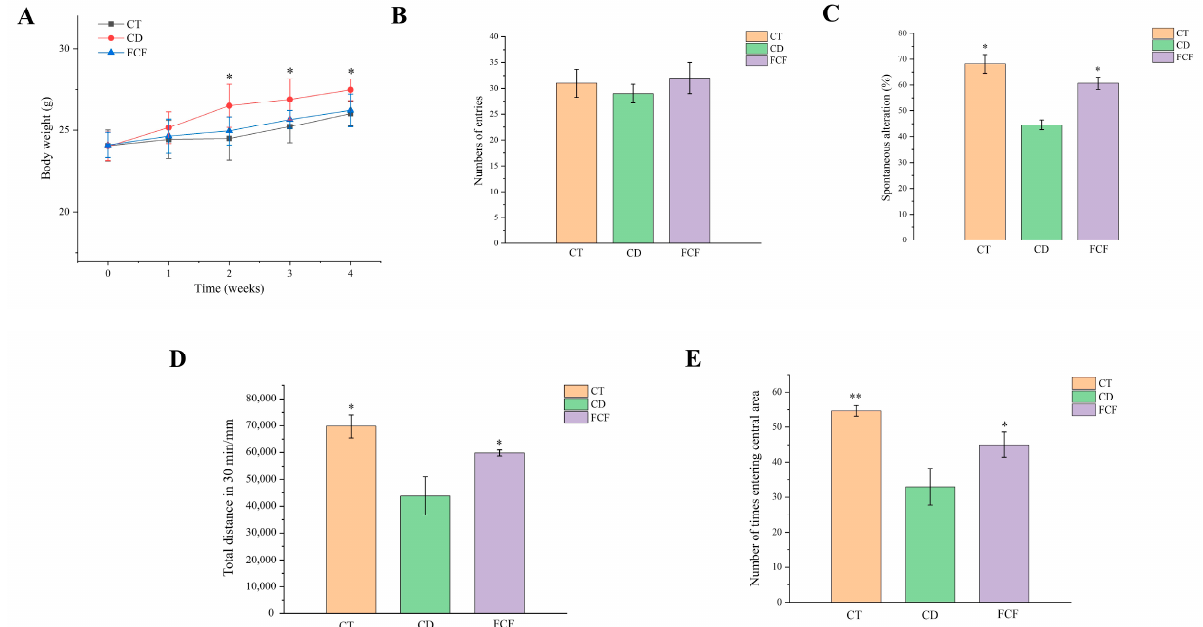
Figure 1. ( A ) Effect of FCF on the body weight of circadian rhythm disorder mice. * p < 0.05, compared with the CD group. The effect of FCF on the total number of arm entries ( B ) and the correct rate of spontaneous alternation ( C ) in mice with circadian rhythm disorder. The effect of FCF on the total 30 min exercise distance ( D ) and the times of entering the central area ( E ) in mice with circadian rhythm disorder. * p < 0.05, ** p < 0.01, compared with the CD group.